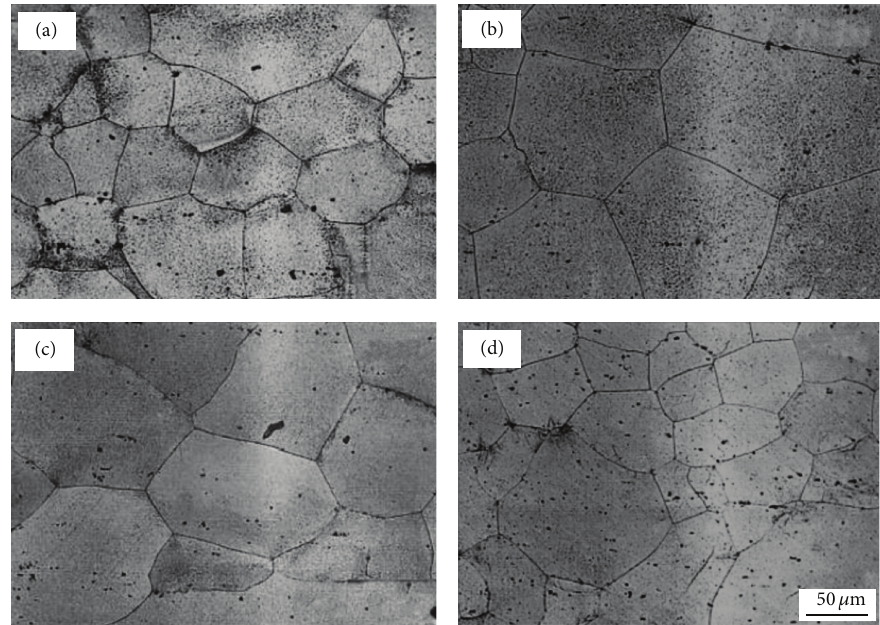
Figure 4: Micrographs of solution-treated specimens: (a) LAZ1110, (b) LAZ1110+Be, (c) LAZ1110+Sc, and (d) LAZ1110+Be+Sc [1].